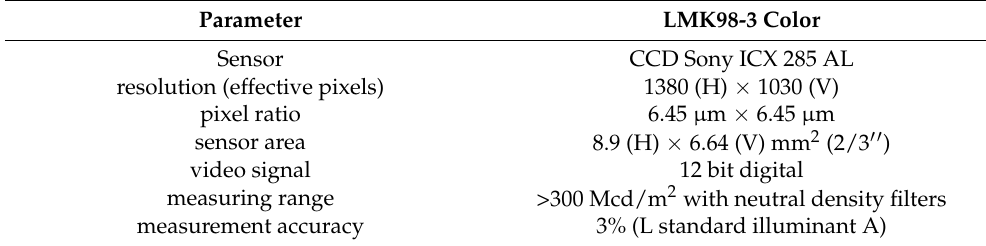
Table 1. Technical parameters of the LMK98-3 Color luminance